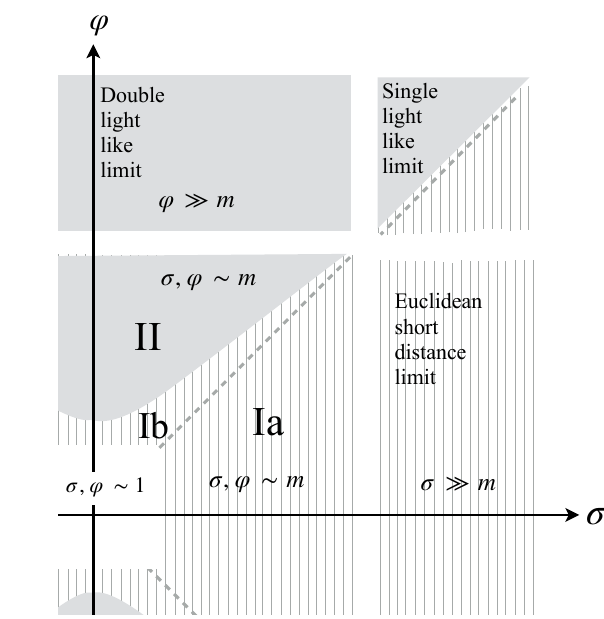
Figure 1 . The scaling regimes of a large rectangular (cid:12)shnet. The double scaling domain σ, ϕ ∼ m is split into regimes I and II. In regime I (the hatched area | ϕ | ≤ b )) the solution for the spectral density does not depend on ϕ . In the domain | ϕ | < | σ | (regime Ia) this is so also for the free energy while for | σ | < ϕ ≤ b (regime Ib) the free energy contains a term mϕ . The solution in regime I relates analytically the bulk thermodynamical limit c σ, ϕ ∼ 1 and the Euclidean short distance limit σ (cid:29) m . In regime II (the grey domain | ϕ | ≥ b ) the solution depends on both σ and ϕ . The double light-cone limits is attained in regime II by taking ϕ (cid:29) m with σ (cid:12)nite. The single light-cone limit is reached by taking ϕ (cid:29) m with µ = ϕ − σ